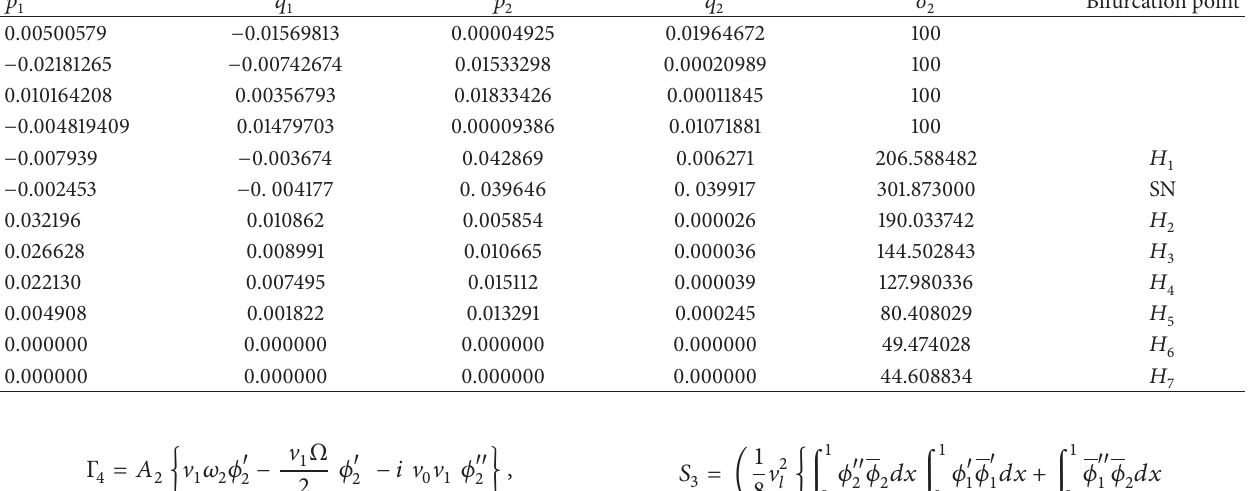
Table 2: Typical points on the different branches of the frequency response for 𝜇 = 0.1 , 𝛼 = 0 , V 1 = 10 , V 1 = 40 , and 𝜎 1 = 92.39